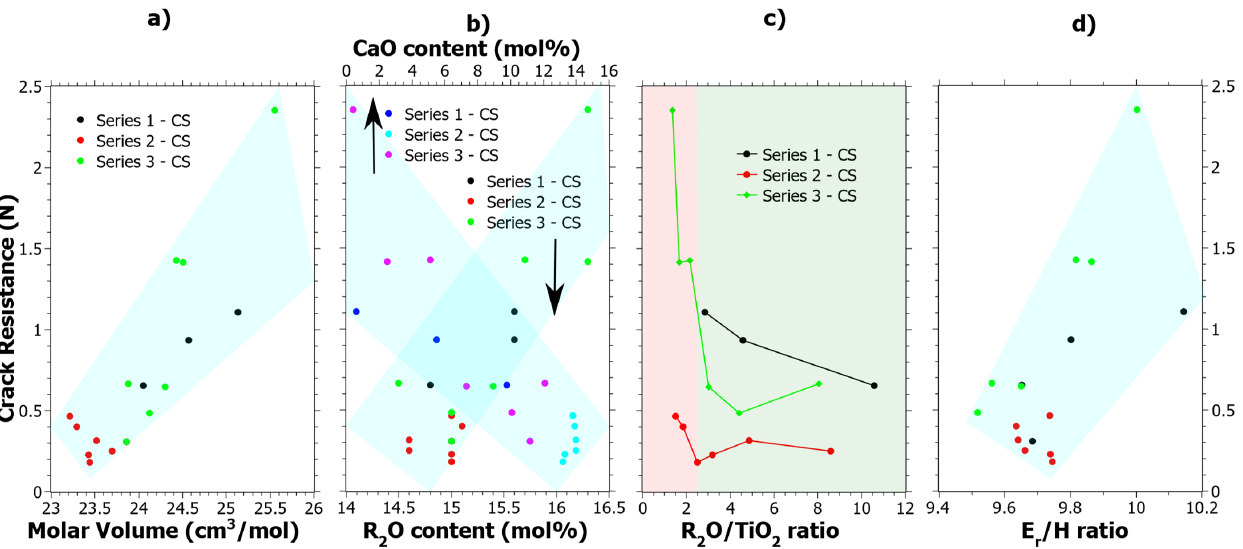
Figure 6. Crack resistance correlation to ( a ) Molar Volume ( V m ), ( b ) R 2 O content where R = Na or K, ( c ) Ti 4+ coordination as shown by the R 2 O/TiO 2 ratio where the red semi-transparent color indicates a mixture of four- and five-coordinated Ti 4+ and the green color primarily tetrahedrally coordinated Ti 4+ and ( d ) the E r /H ratio as calculated from the data in Figure 1, i.e., 75 mN nano-indentation load. The semi-transparent colored areas are guides for the eye.